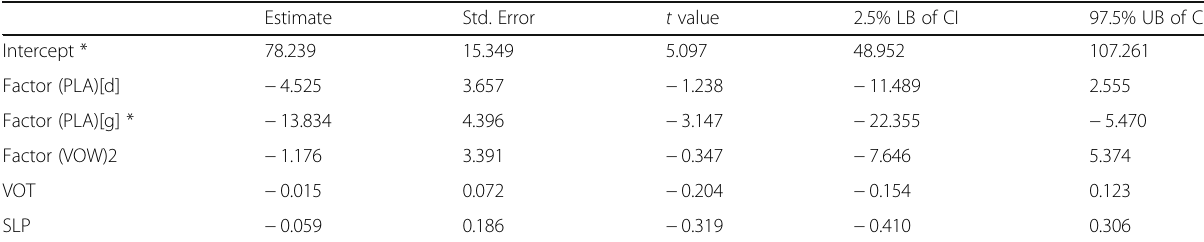
Table 12 Fixed effects results